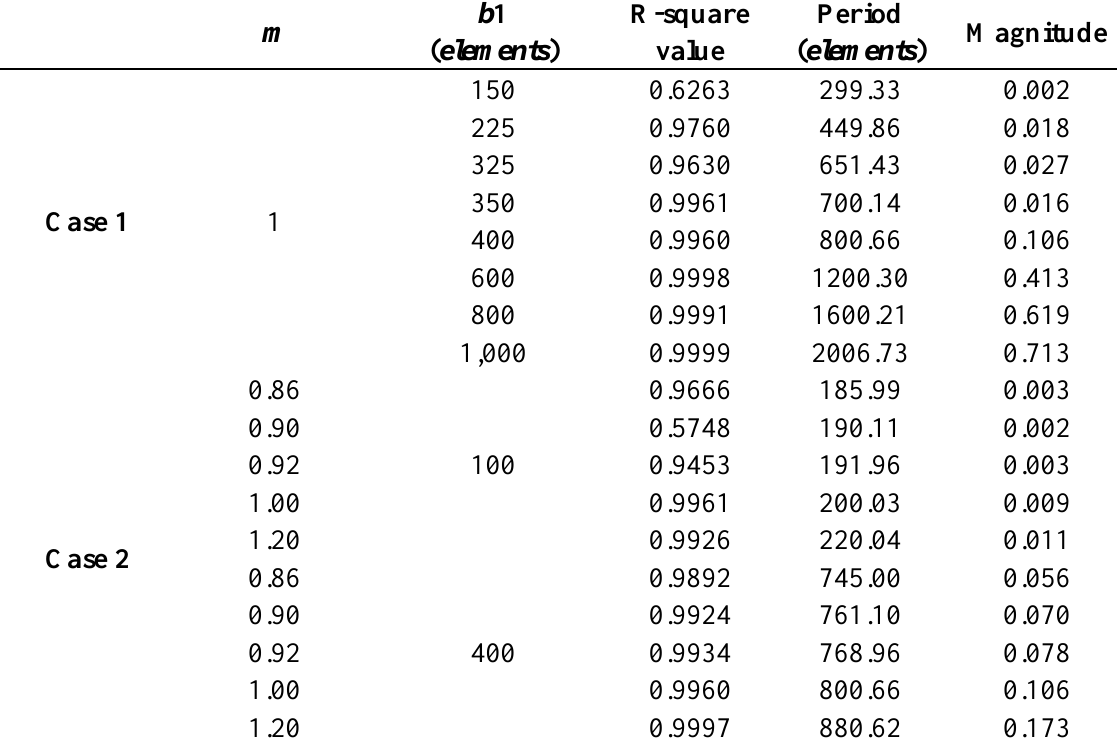
Table 2. R-square values, periods, and magnitudes of each grating pattern via sine curve fitting